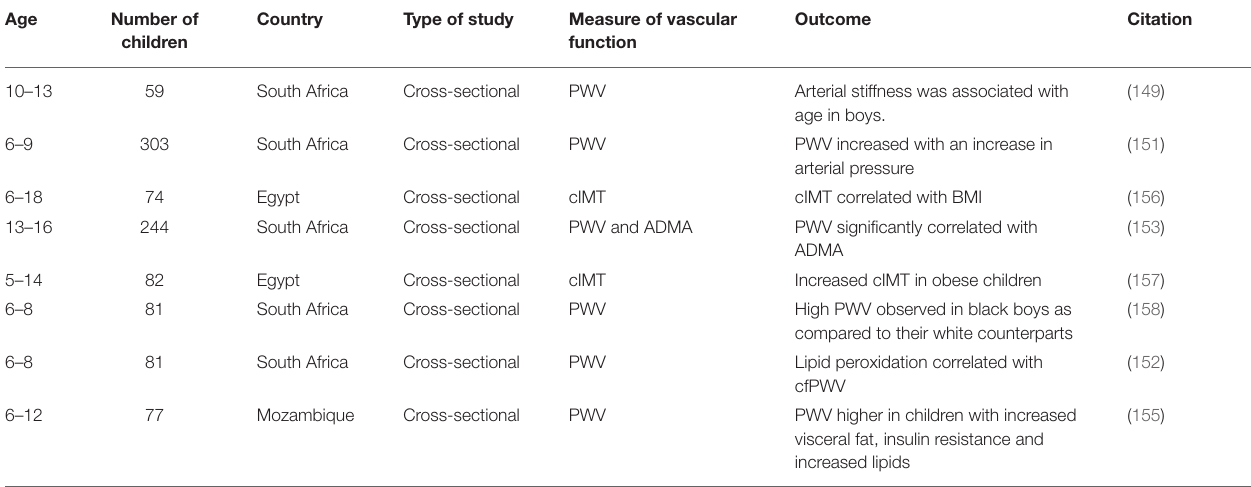
TABLE 2 | Vascular dysfunction and their associated risk factors in African